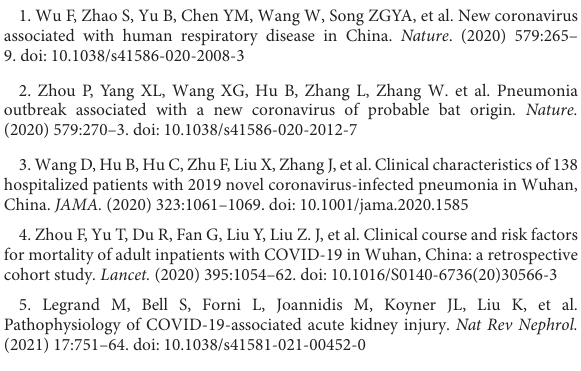
table preparation. XH and ZT contributed to the statistical analysis. JZ, DZ, and JH contributed equally to this work.